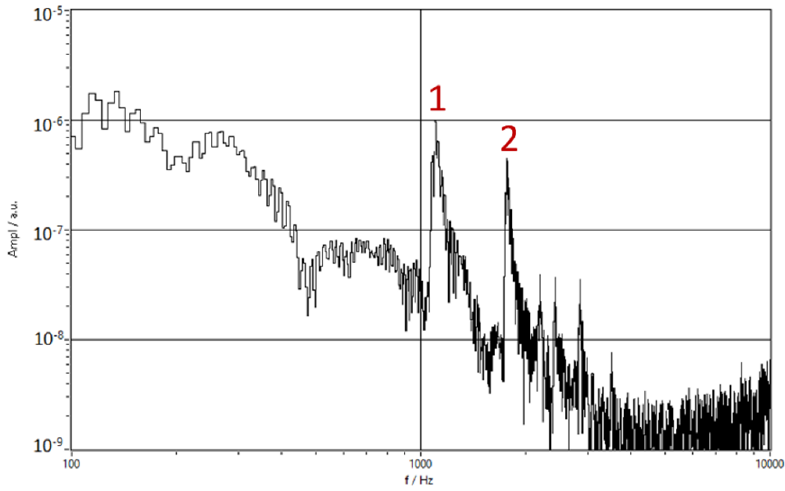
Figure 16. FFT spectrum of the returned signal, the marked peaks were used to calculate speed of sound.